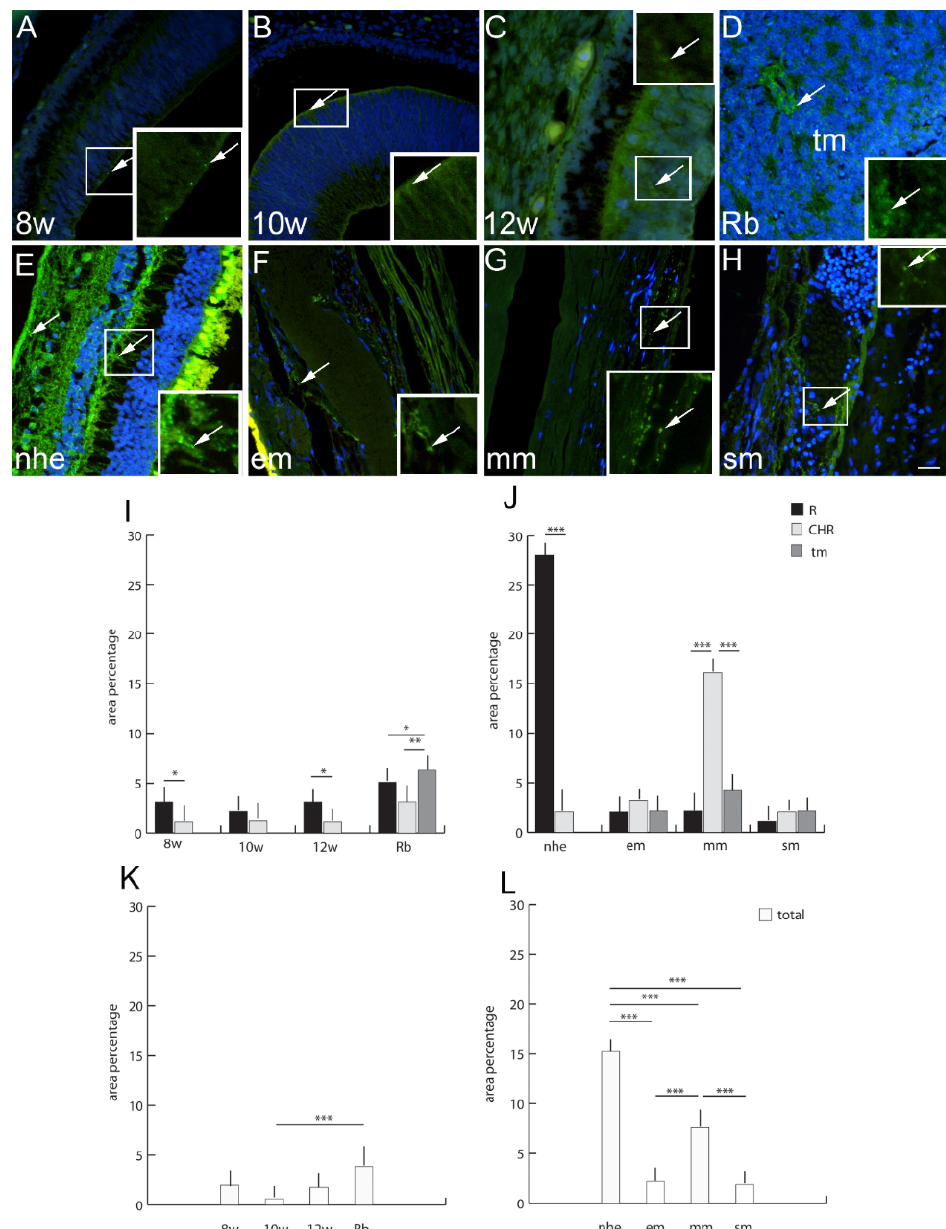
Figure 3. Connexin 40 (Cx40)-positive cells (arrows) can be seen in the eye section of an 8th-week (8 w) ( A ), 10th-week (10w) ( B ) and 12th week (12 w) ( C ) human embryo, retinoblastoma (Rb) ( D ), normal human eye (nhe) ( E ), epitheloid melanoma (em) ( F ), mixoid melanoma (mm) ( G ) and spindle melanoma (sm) ( H ); tm—tumor tissue. Immunofluorescence staining to Cx40 (green) merged to DAPI (blue nuclei), scale bar 25 μ m. The panel with graphs represents the area percentages of Cx40 in the retina (R), choroid (CHR) and tumor (tm) in the 8th-week (8 w), 10th-week (10 w) and 12th week (12 w) human embryo, retinoblastoma (Rb), normal human eye (nhe), epitheloid melanoma (em), mixoid melanoma (mm) and spindle melanoma (sm) ( I , J ), and total area percentage of Cx40 ( K , L ). Data are shown as mean ± SD. Significant differences are indicated by * p < 0.05, ** p < 0.01, and *** p < 0.001. One-way ANOVA followed by Tukey’s multiple comparisons test (comparison between Rb and uveal melanoma types), t -test (comparison between retina and choroid of develop- mental stages and normal human eye).